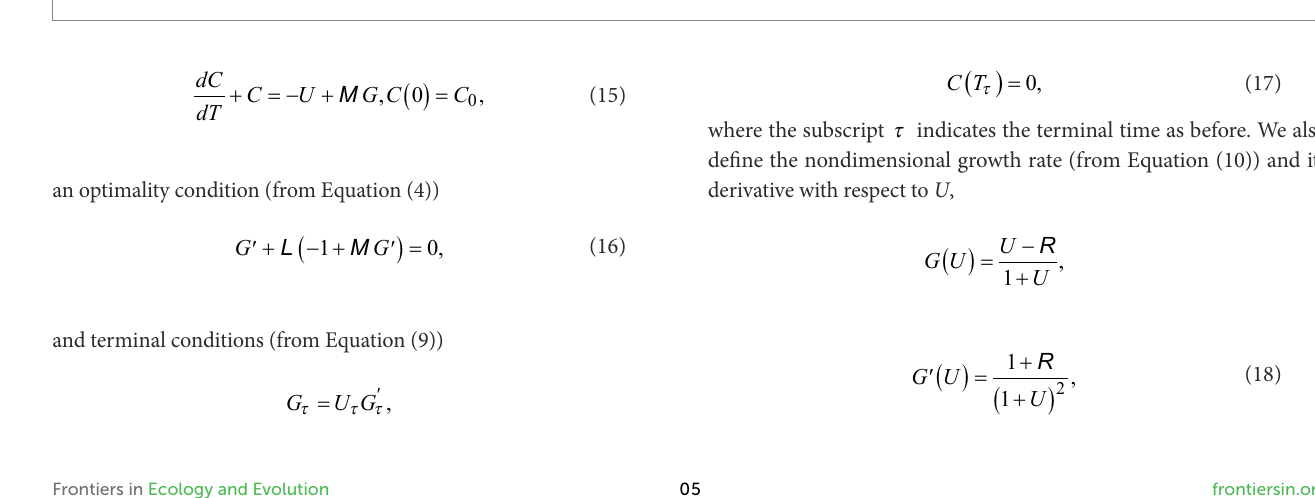
FIGURE 2 Effects of the half saturation constant of the microbial growth rate ( b , left panels) and of the first-order decay constant ( g , right panels), for two values of maintenance respiration ( r ) and maximum growth efficiency ( max e ) on: (A,B) the relation between growth rate and decomposition rate, g ( u ); (C,D) the temporal trajectory of the optimal decomposition rate, u ( t ); and (E,F) the temporal trajectory of the substrate carbon, c ( t ). In all panels: 0 c = 1 g, m= 0.5. In (B) , curves with the same g value overlap, because g ( u ) does not depend on g . Parameter units are as in Table